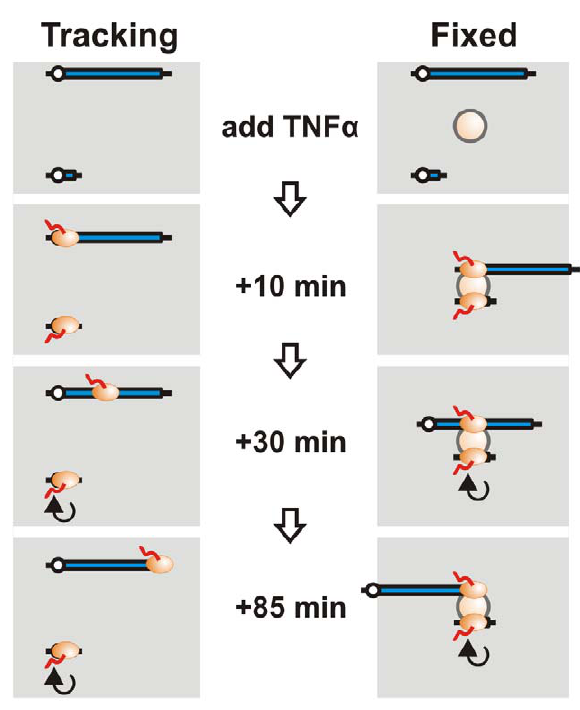
Figure 1. Distinguishing between tracking and fixed RNA polymerases. Before adding TNF a , both the long and short gene are not transcribed. Assuming they lie far apart on the same chromosome, they are unlikely to yield detectable 3C products. Ten min after